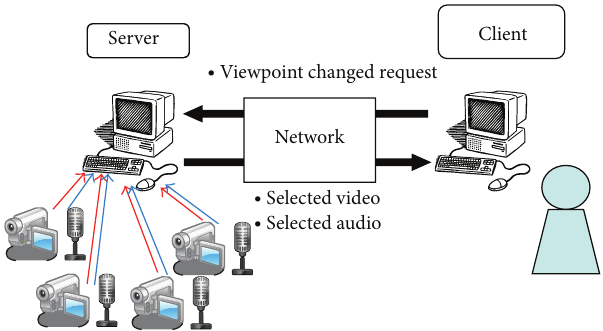
Figure 1: MVV-SA system.